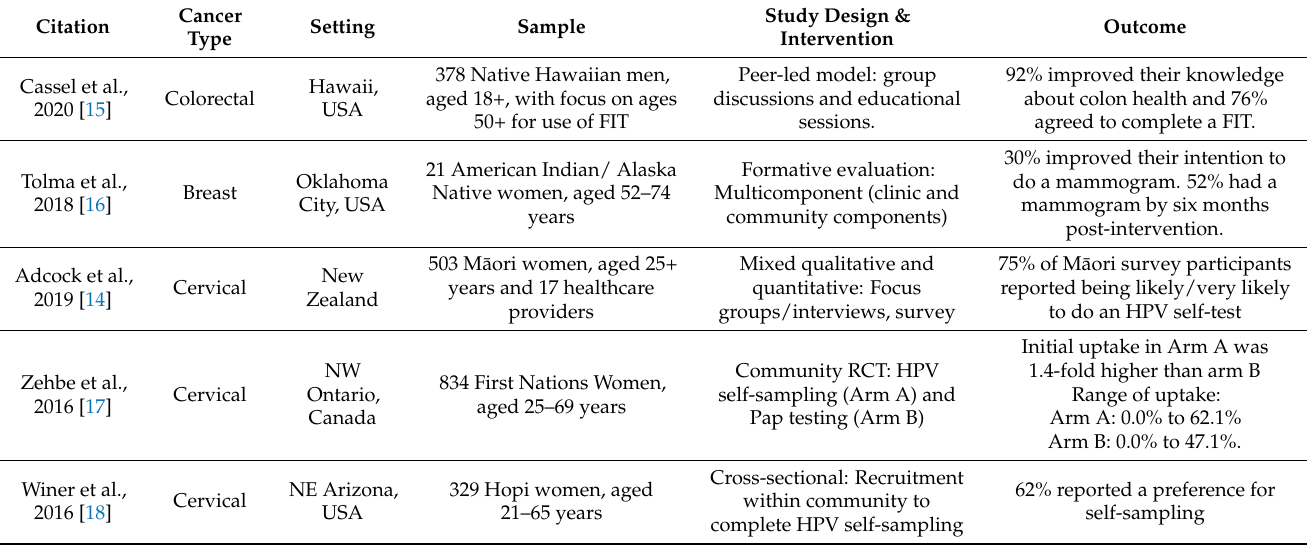
Table 4. Interventions that improved knowledge, attitude, or intention to